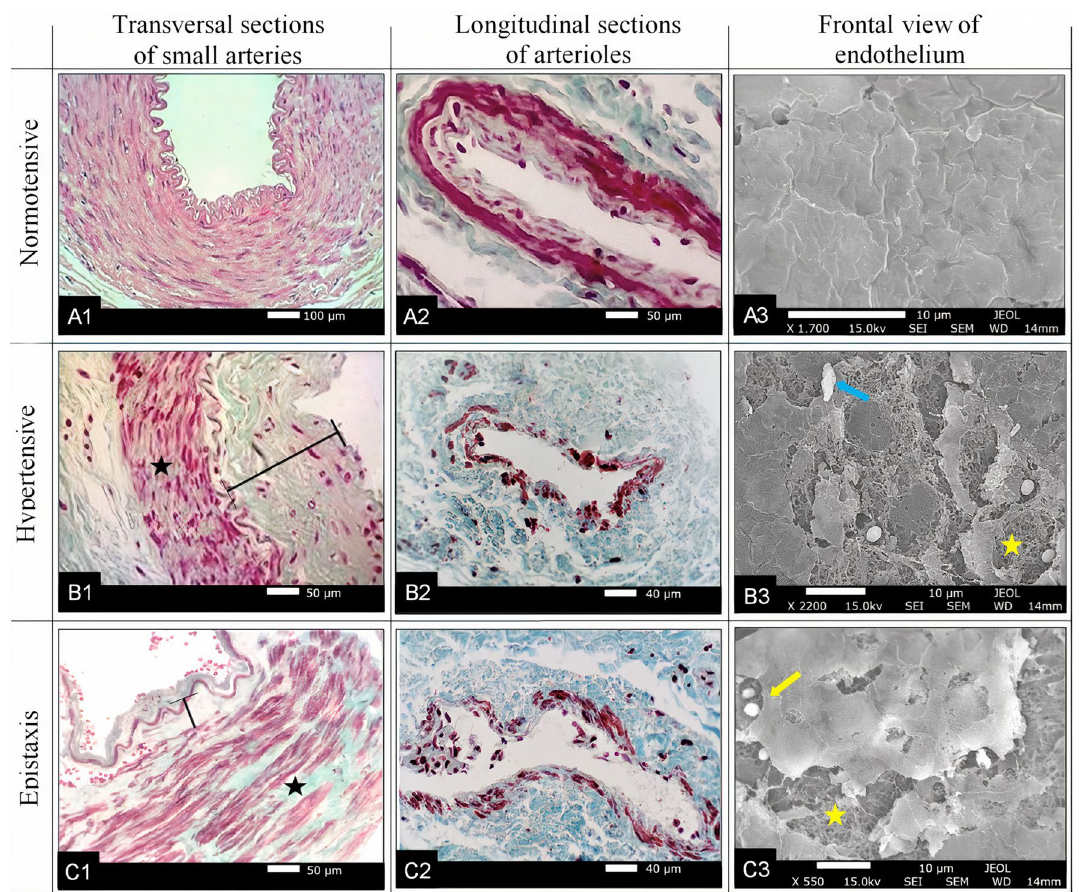
Figure 1. Photomicrographs and scanning electromicrographs obtained from fragments of the posterior nasal mucosa of normotensive individuals, hypertensive individuals and which are representative of the structural evaluation of the branches of the sphenopalatine artery. Observe the normal layers ( A1 , Hematoxilin & Eosin; A2 , Gomori) and arteries exhibit areas in which muscle cells lost juxtaposition and greater presence of extracellular matrix (black star) ( B1 , B2 , C1 , C2 ; Gomori Trichrome) and larger intimal layer (black bars) ( B1 , C1 ). The third column shows the frontal view of the intima from three individuals ( A3 = normotensive; B3 = hypertensive; C3 = epistaxis) showing that the endothelial cells are adhered and continuous in normotensive ( A3 ), whereas in ( B3 , C3 ) it is possible to observe regions with endothelial loss (yellow star), platelets (yellow arrow) and a leucocyte (blue arrow) attached to the lamina